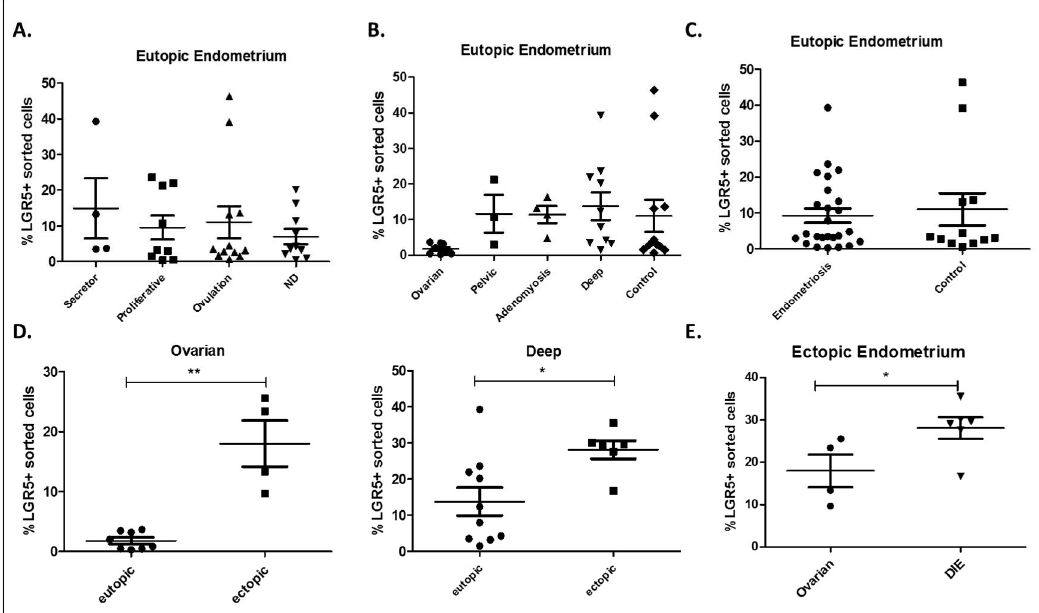
Figure 3. Percentage of FACS-sorted LGR5 + cells. ( A ) Percentages of LGR5 + cells in different phases of the cycle (proliferative: n = 9; secretory: n = 4; ovulatory: n = 12; ND: n = 9). ( B ) Percentage of LGR5 + cells in eutopic endometrium of different types of endometriosis and controls (ovarian: n = 8; pelvic: n = 3; adenomyosis: n = 4; DIE: n = 10; control: n = 12). ( C ) Percentage of LGR5 + cells identified in eutopic endometrium of women with and without endometriosis (control: n = 12; endometriosis: n = 25). ( D ) Differences in LGR5 + cells between eutopic and ectopic endometrium. Left panel: ovarian endometriosis (eutopic: n = 8; ectopic: n = 4; p = 0.0286). Right panel: DIE (eutopic: n = 10; ectopic: n = 6; p = 0.0411). ( E ) Difference between ovarian and DIE ectopic endometrium (ovarian: n = 4; DIE: n = 6; p = 0.0381). ND: non-determined; DIE: deep infiltrating endometriosis. * p < 0.05, ** p < 0.03.